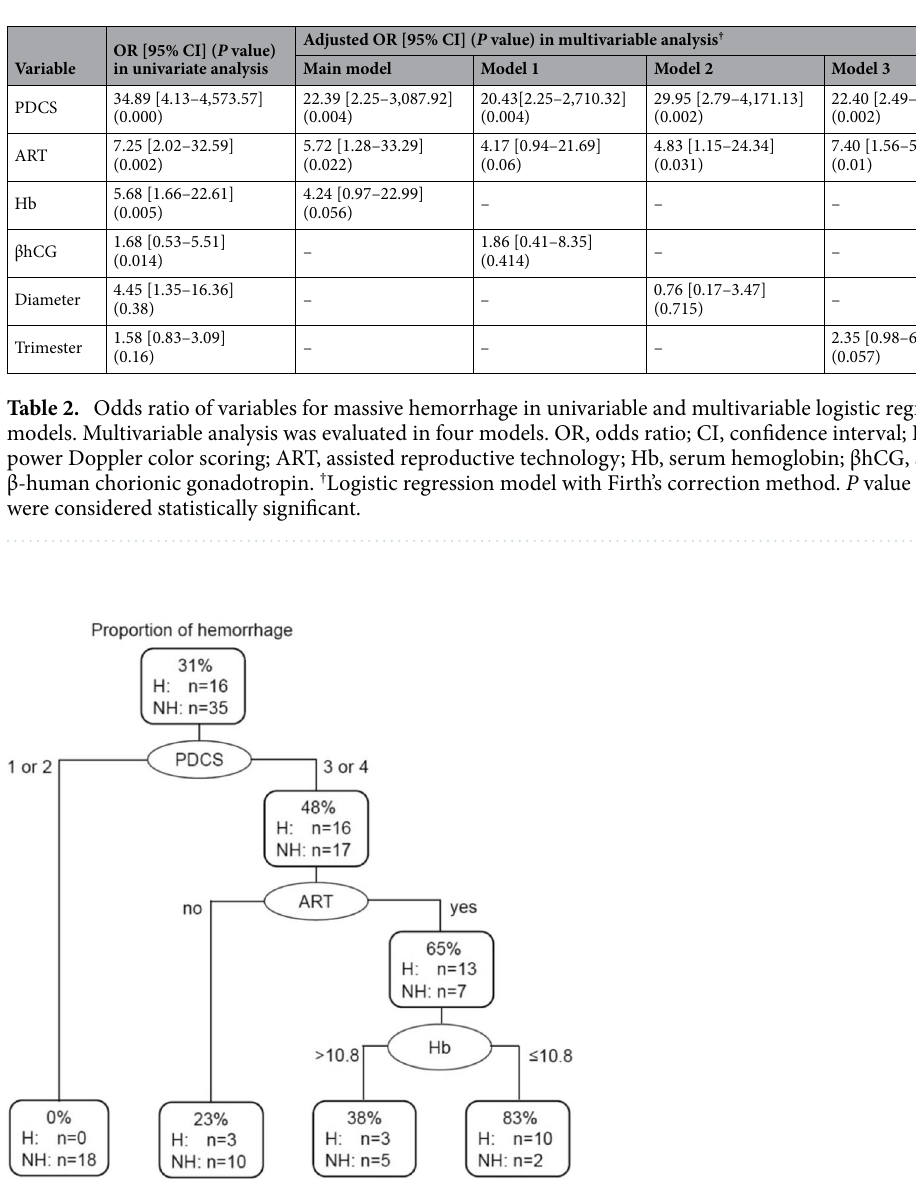
Figure 2. Decision tree model of predictive factors for massive hemorrhage. Decision tree method identified PDCS, ART, and serum Hb levels as effective variables in massive hemorrhage prediction. H: hemorrhage, NH: no hemorrhage, PDCS: power Doppler color scoring, ART: assisted reproductive technology, Hb: serum hemoglobin. βhCG: serum β-human chorionic gonadotropin, ROC: receiver operating